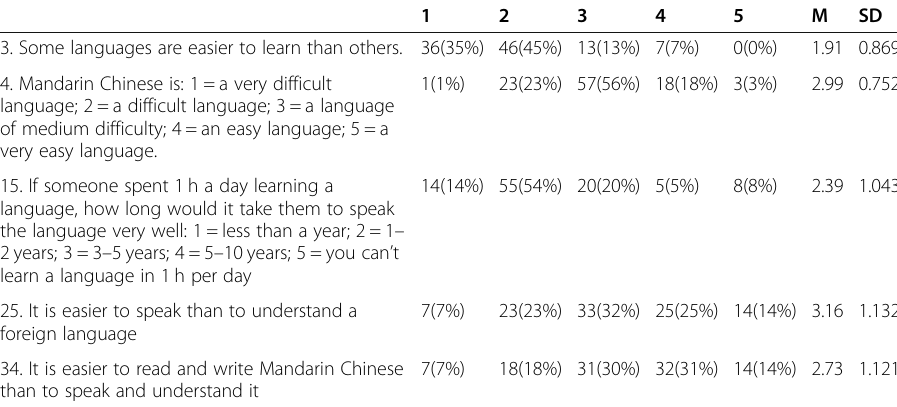
Table 1 Frequency of Participant Responses to BALLI items on Difficult of Language